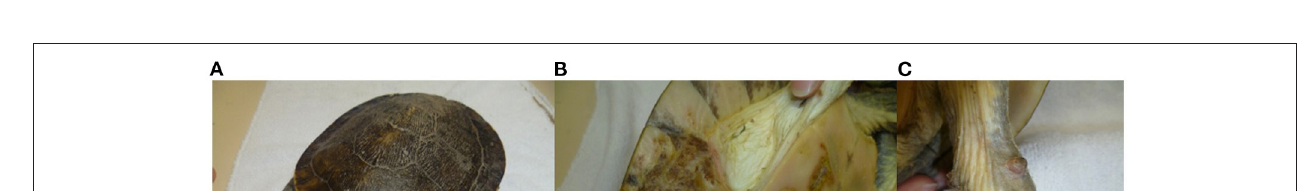
FIGURE 6 | Fibropapillomatosis in green turtle ( Chelonia mydas ). Photo by Dr. Karina Jones.